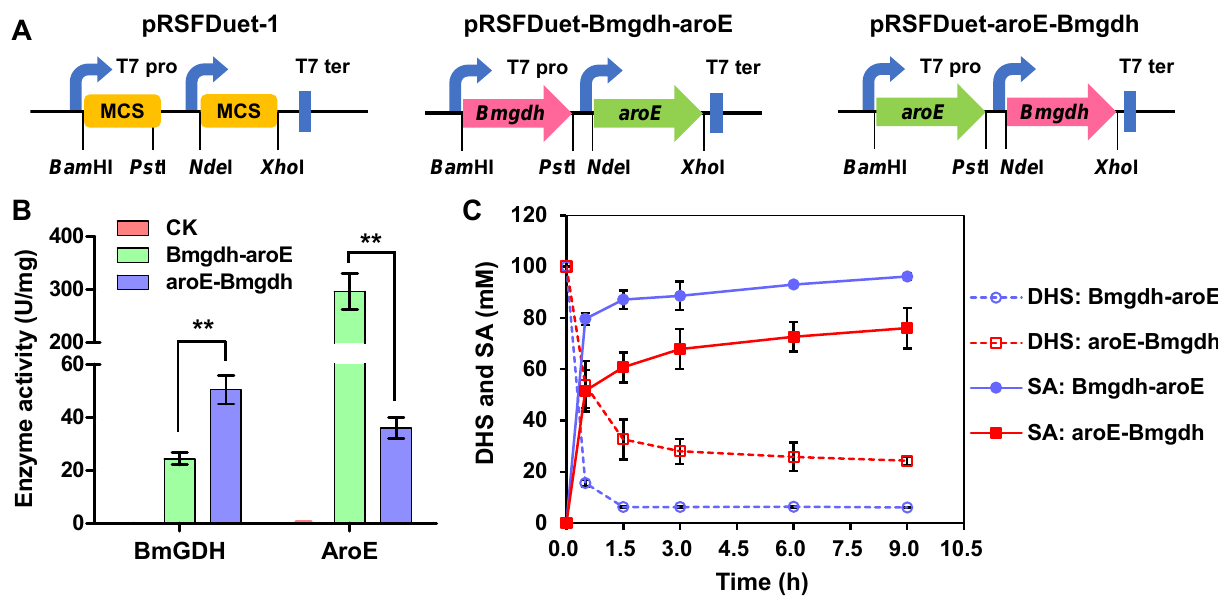
Figure 4. The effect of expression order for Bmgdh and aroE on the catalytic efficiency of whole-cell biocatalysts. ( A ) Simple diagrams of the plasmids for pRSFDuet-1, pRSFDuet-Bmgdh-aroE, and pRSFDuet-aroE-Bmgdh; ( B ) enzyme activities of BmGDH and AroE in the cell-free extracts of recombinant strains. The BL21(DE3) strain transformed with empty pRSFDuet-1 plasmid was used as the negative control (CK); ( C ) time courses of DHS and SA concentrations catalyzed by two types of whole-cell biocatalysts co-expressing Bmgdh – aroE or aroE – Bmgdh . The cells were harvested from